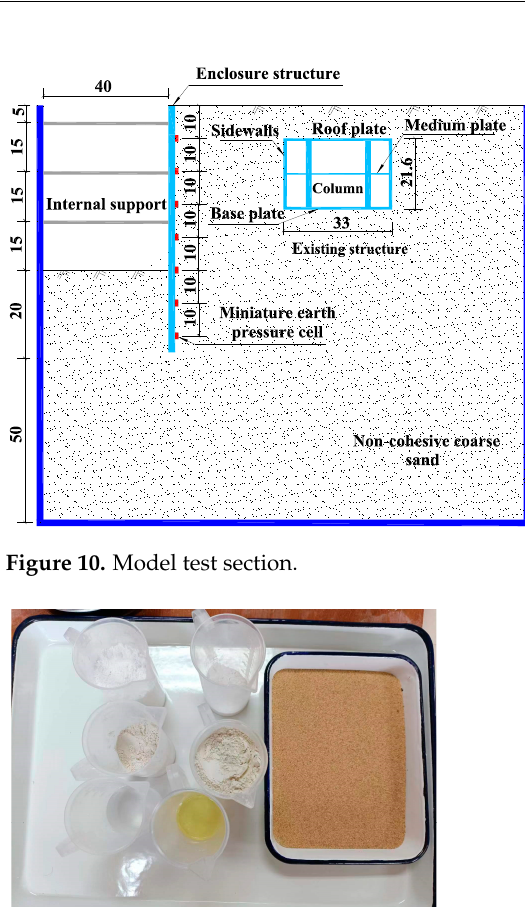
Figure 11. Raw materials of similar soil. Table 1. Specific gravity of similar soil.